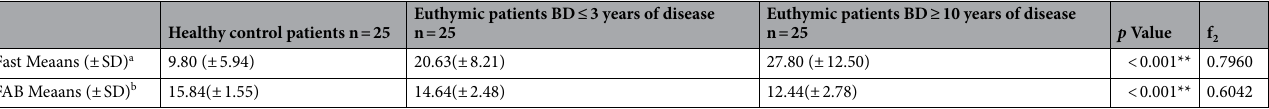
Euthymic patients BD ≤ 3 years of disease n = 25